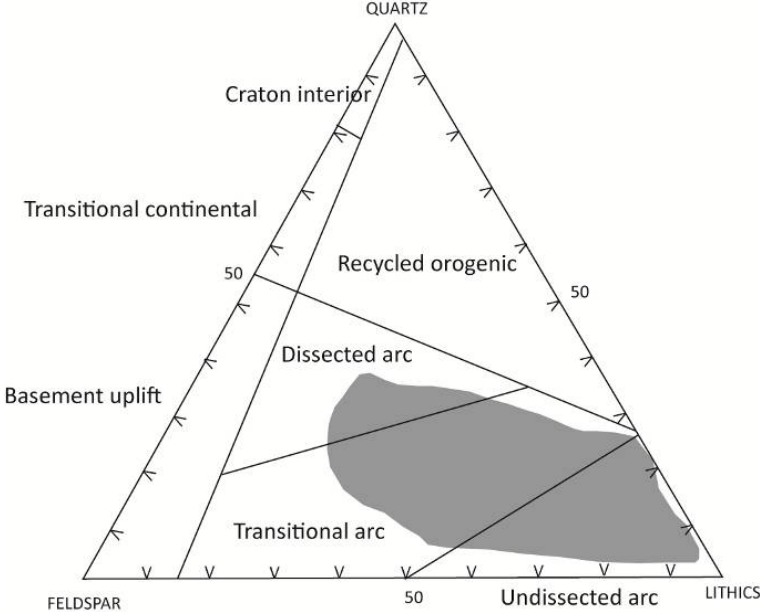
Figure 15. Quartz-feldspar-lithics diagram showing the provenance and plate tectonic setting for sandstone in the Murdama group. Sandstone data (dark gray field) after [50]; provenance fields after [60,61].